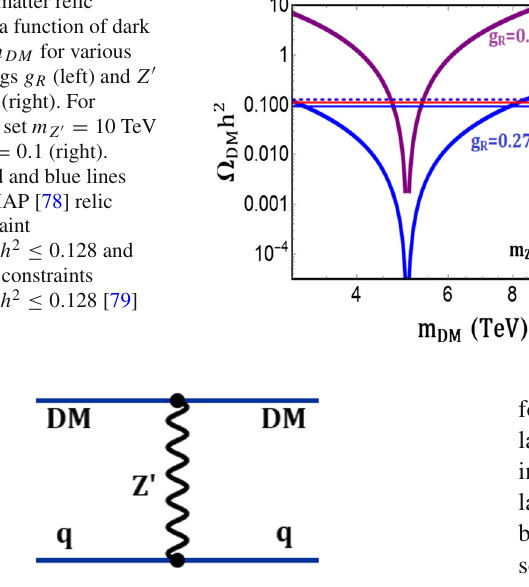
Fig. 10 Representative Feynman diagram for the DM-nucleon scatter- ing for the DM direct detection